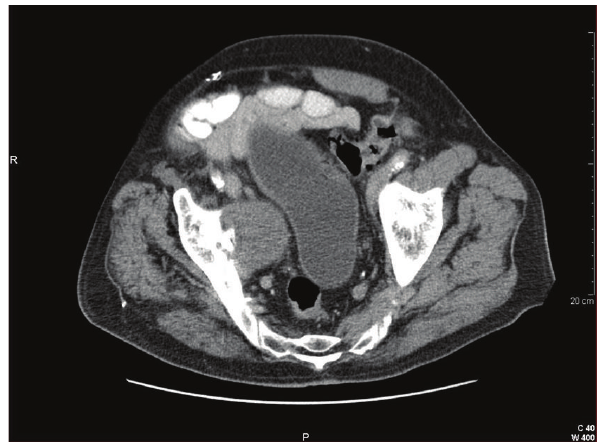
Figure 2: CT scan of pelvis revealing large mass to be extrinsic to bladder